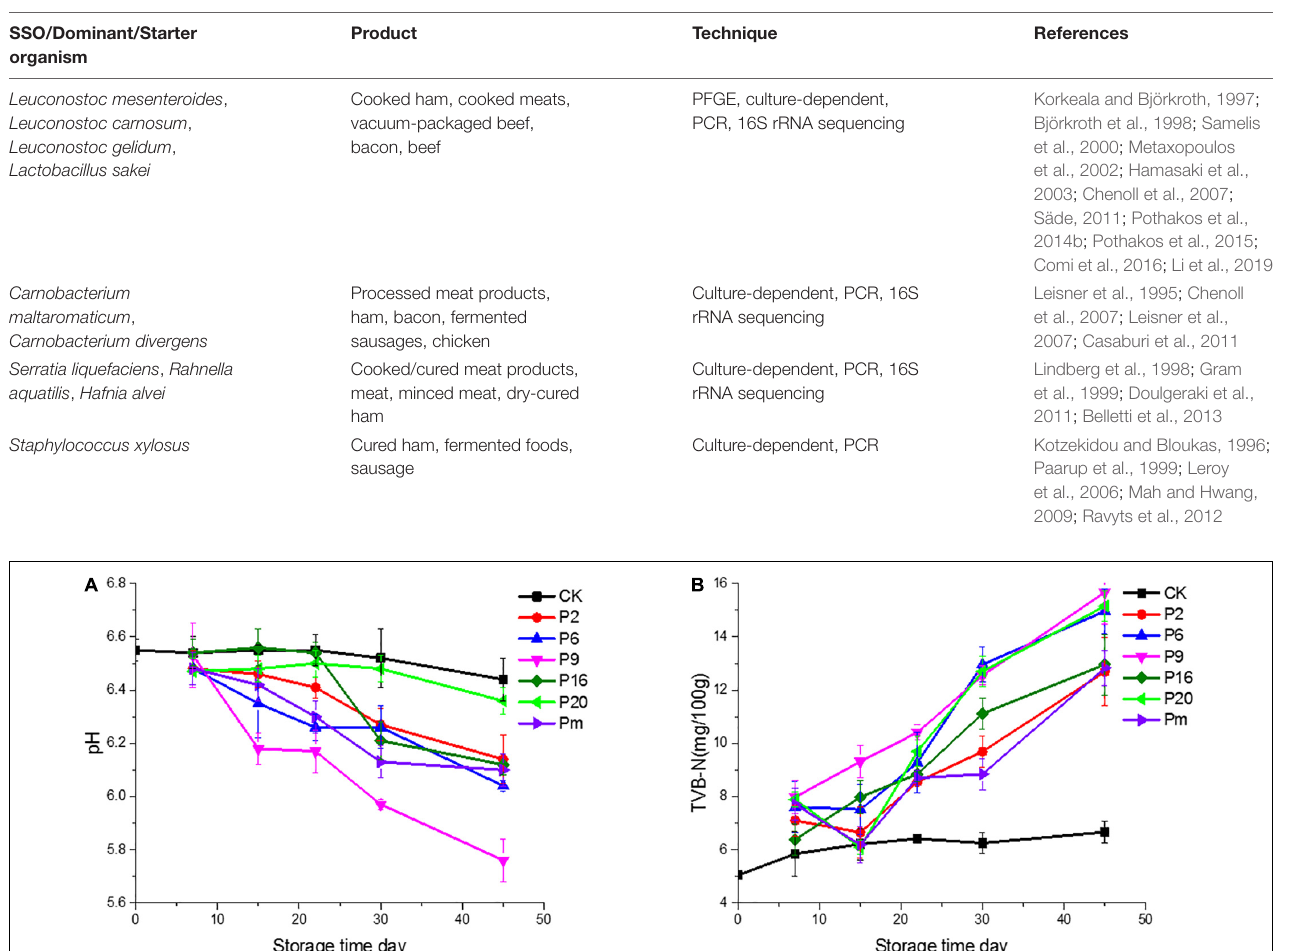
propagation at 30 ◦ C for 24 h. Thereafter, 0.1 mL was